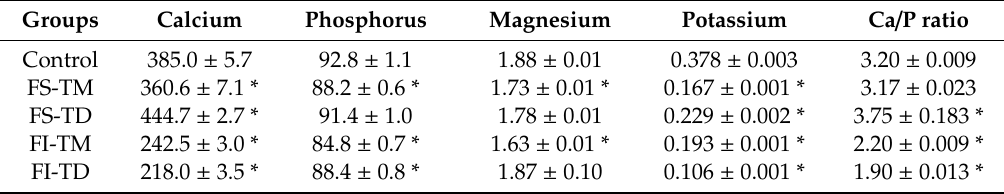
Table 5. Mineral content and Ca / P ratio within the femur of rats fed with experimental diets (mg / g). Groups Calcium Phosphorus Magnesium Potassium Ca / P ratio Control 385.0 ± 5.7 92.8 ± 1.1 1.88 ± 0.01 0.378 ±